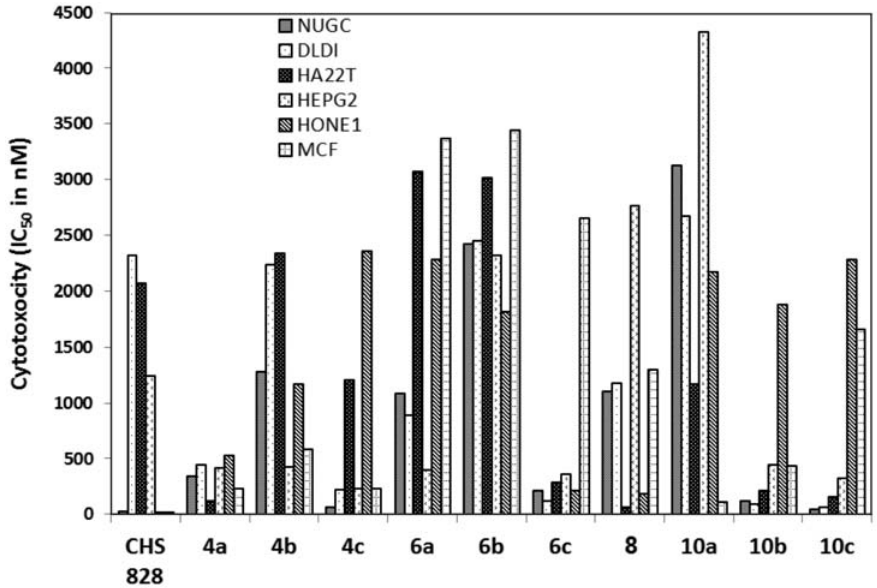
Figure 2 . Cytotoxicity of compounds 4a – c , 6a – c , 8 , 10a – c and CHS 828 against NUGC (gastric cancer); DLDI (colon cancer); HA22T and HEPG2 (liver cancer); HONE1 (nasopharyngeal carcinoma); MCF (breast cancer).